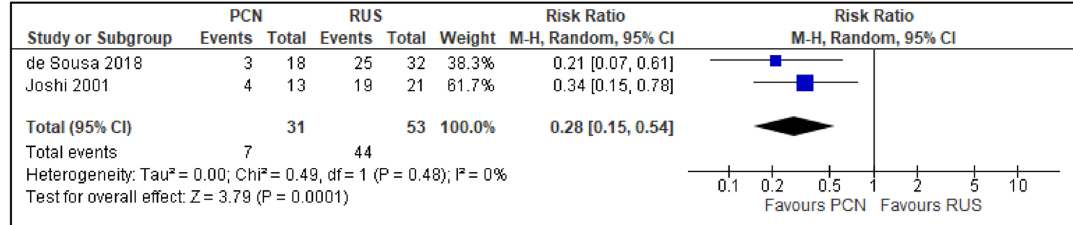
Figure 13. Comparison between PCN and RUS for outcome dysuria.